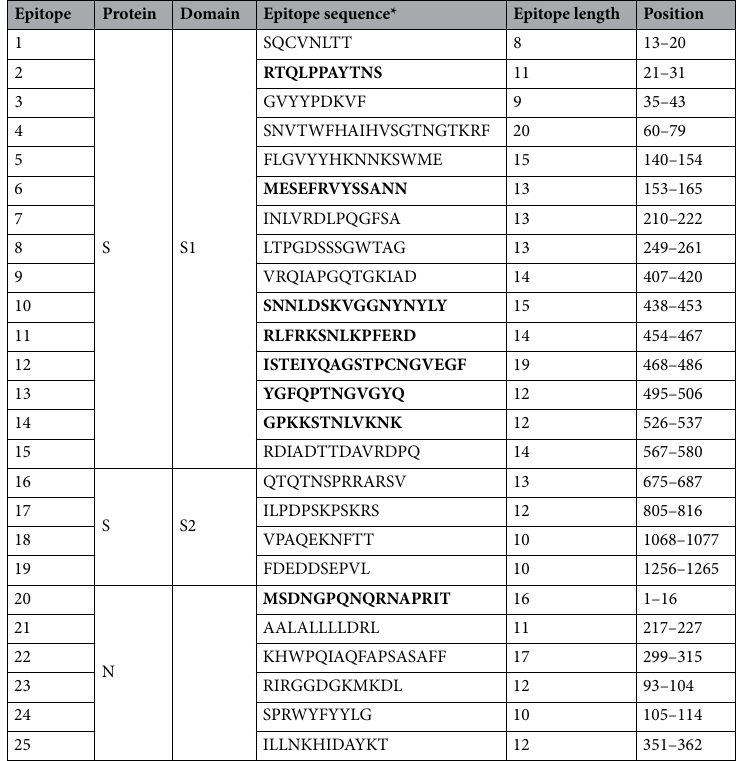
Table 2. Selected immunogenic and antigenic peptides in the S and N proteins of SARS-CoV-2. *In bold: peptides selected for MAP8